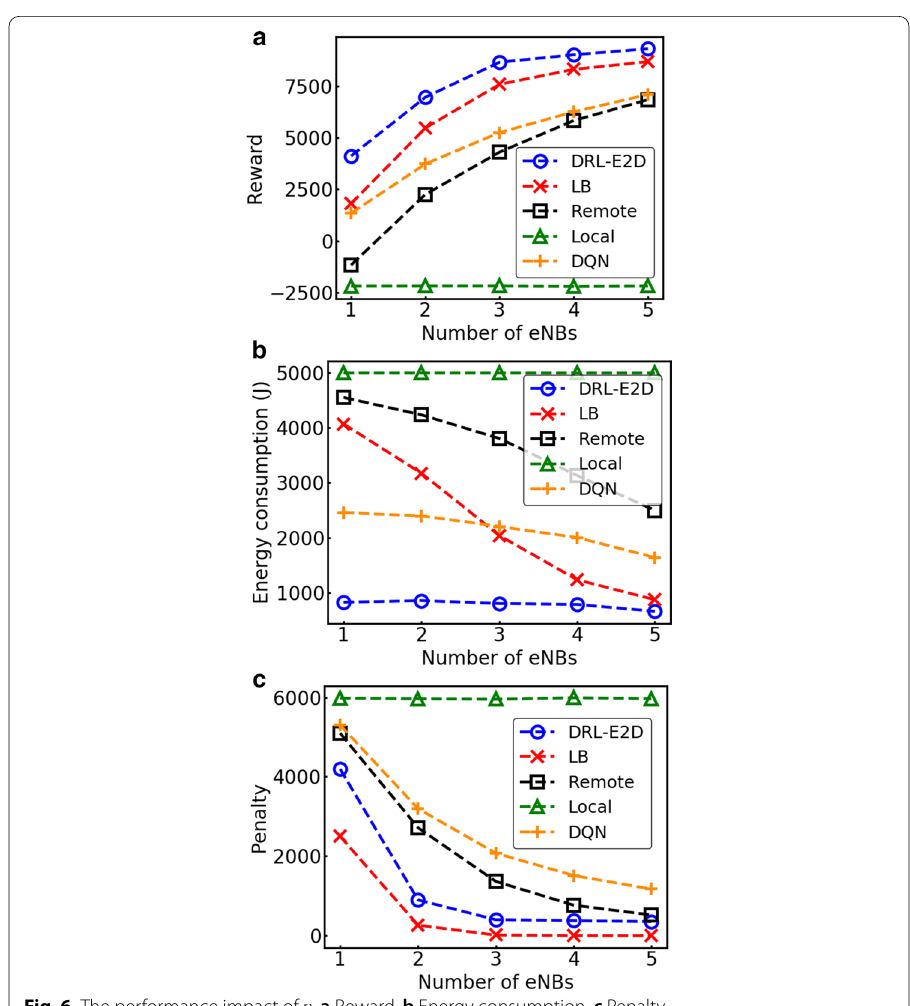
Fig. 6 The performance impact of n . a Reward. b Energy consumption. c